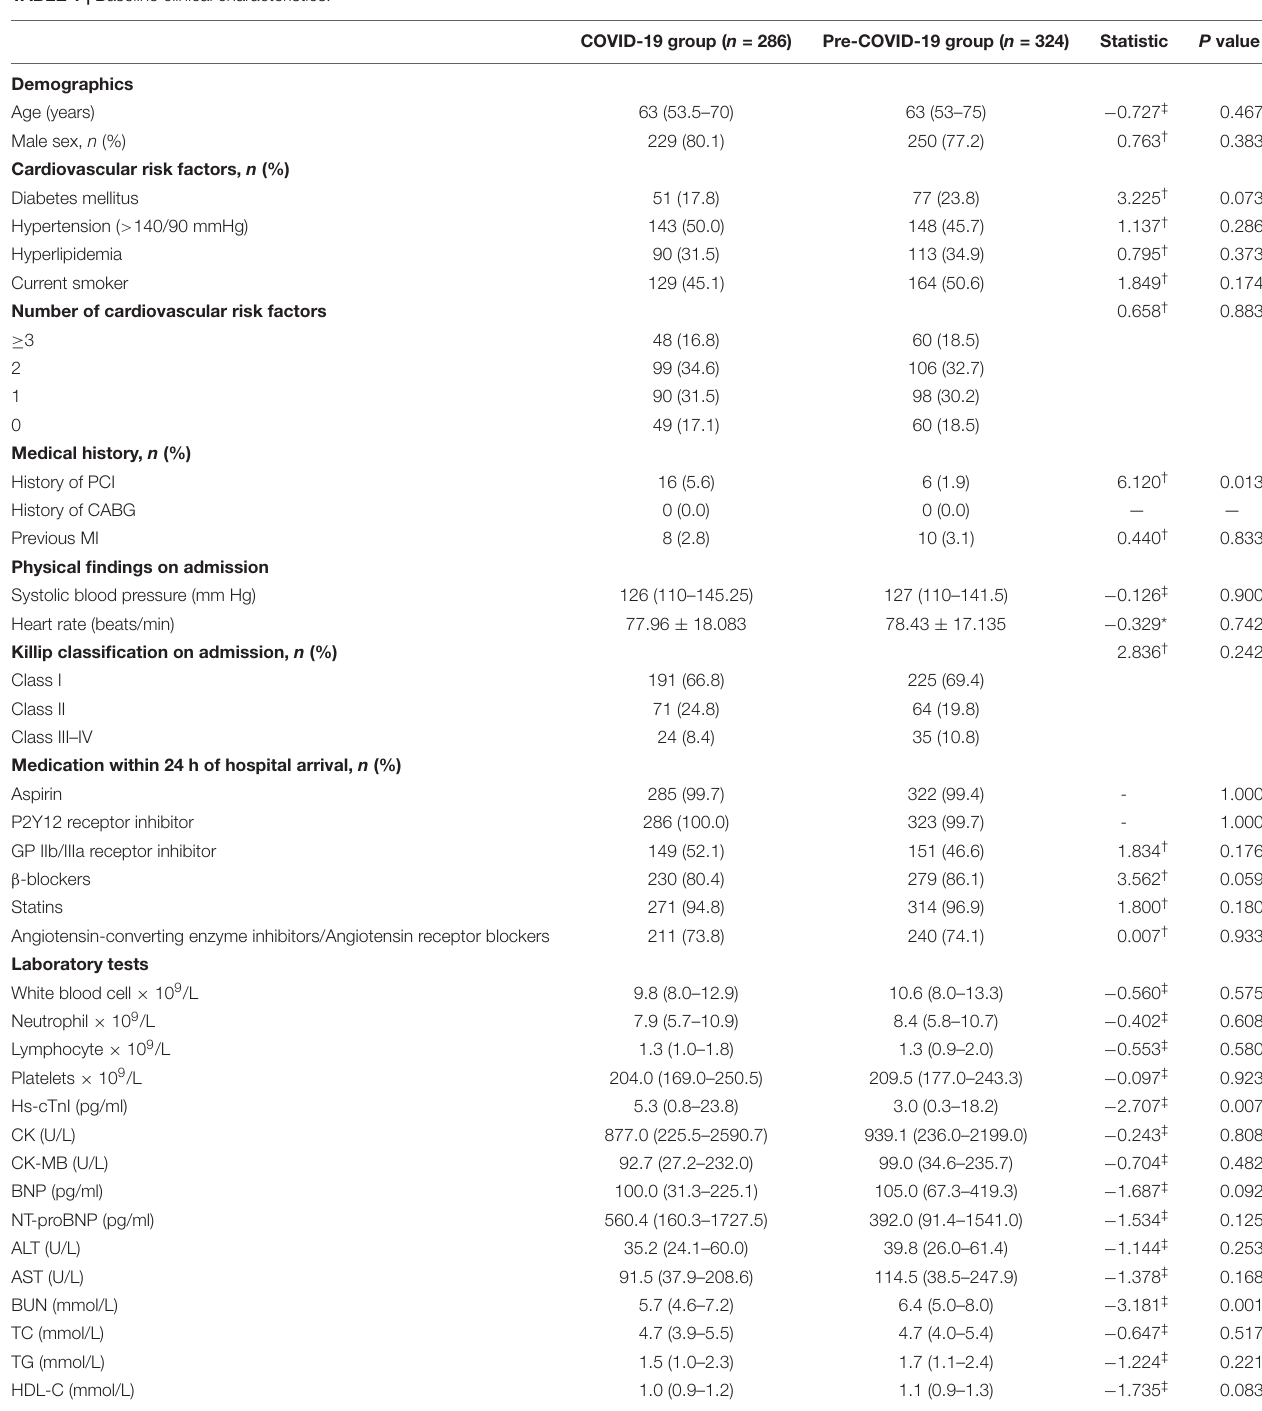
TABLE 1 | Baseline clinical